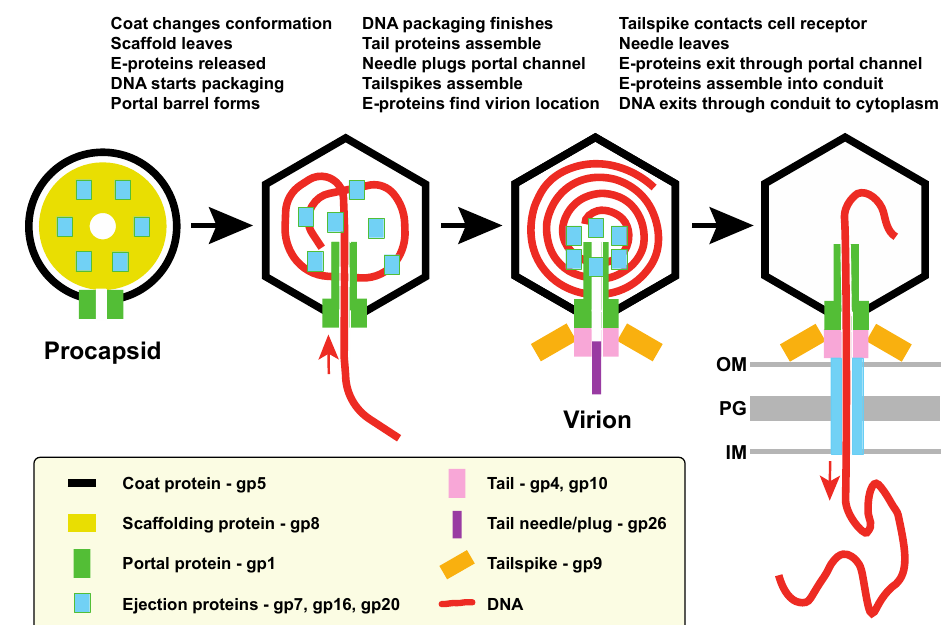
Figure 3. A model for P22 E-protein function. The diagram shows that scaffolding protein recruits the E-proteins into procapsids. The E-proteins are released from scaffold when it exits the structure, and they accumulate near the center of the virion. When the virion binds to a susceptible cell’s receptor, the E-proteins leave the virion through the portal channel and assemble into the trans-periplasmic conduit through which DNA travels into the cell. The order of some steps, for example initiation of DNA packaging, portal barrel formation and E-protein movement to center of particle, have not been resolved (see text). OM, outer membrane; IM, inner membrane; PG, peptidoglycan cell wall.